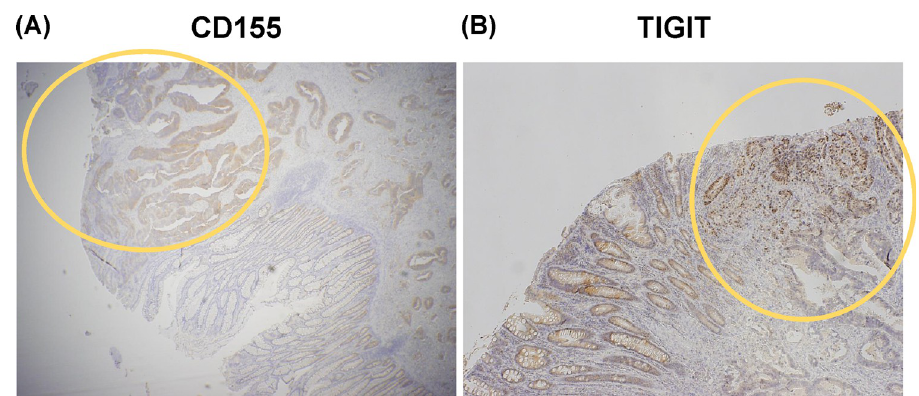
Fig 2. (A) CD155 expression in colorectal cancer and adjacent tissues. The yellow circle is the tumor area. A normal ductal area was observed. CD155 was expressed in malignant epithelial cells of colorectal cancer. (B) TIGIT expression in lymphocytes in colorectal cancer and adjacent tissues. The yellow circle is the tumor area. A normal ductal area was observed. TIGIT was expressed in lymphocytes in colorectal cancer tissues.